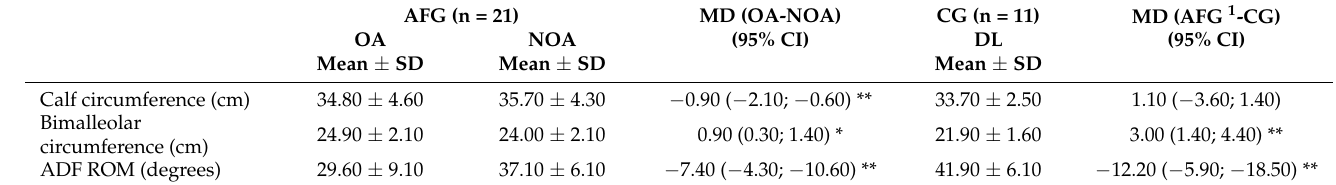
Table 4. Intra-group difference (AFG) between operated ankle/non-operated ankle and between groups (AFG-CG) of ankle circumferences (bimalleolar and calf) and ADF ROM at 12 months post-surgery. AFG (n = 21)